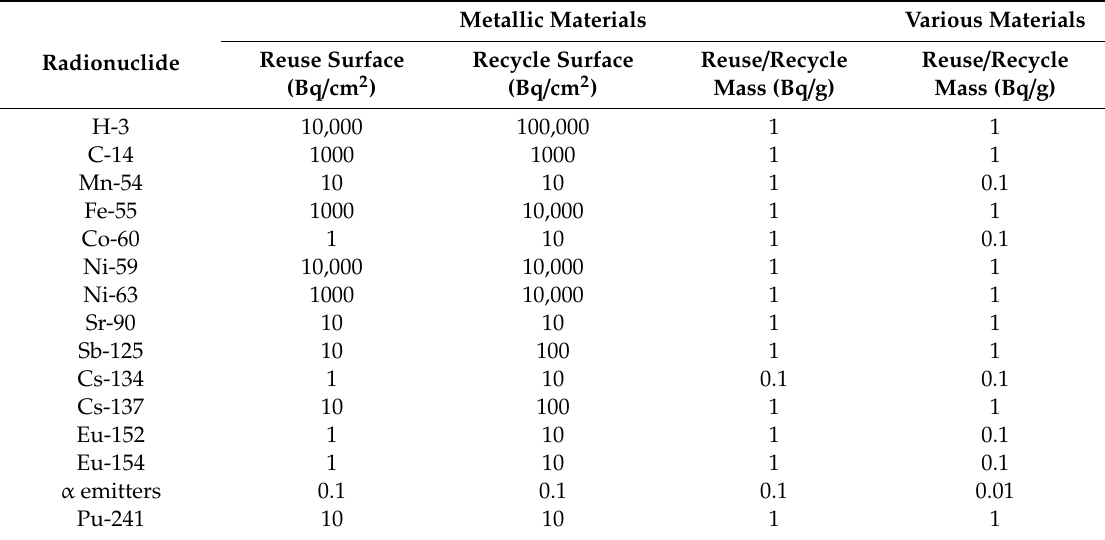
Table 4. Metallic materials and various materials clearance levels. Technical prescriptions attached to the Ministerial Decree 2 August, 2012 of the decommissioning authorization.